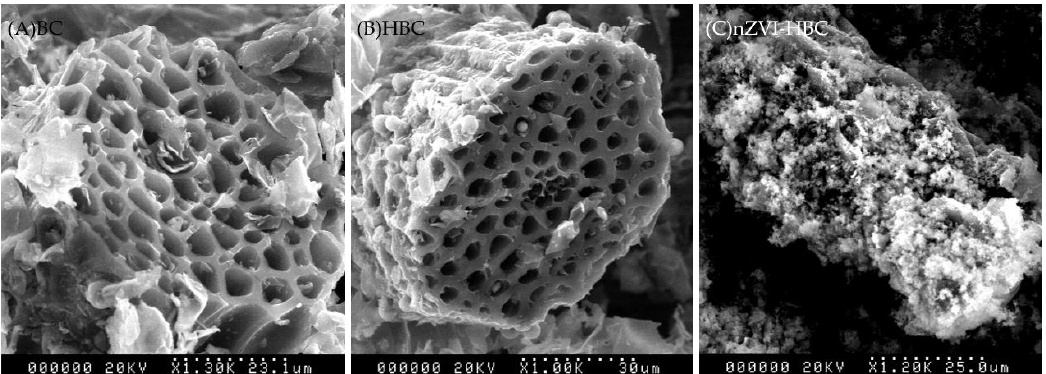
Figure 1. SEM images of biochar. ( A ) BC, ( B ) HBC, and ( C ) nZVI-HBC.